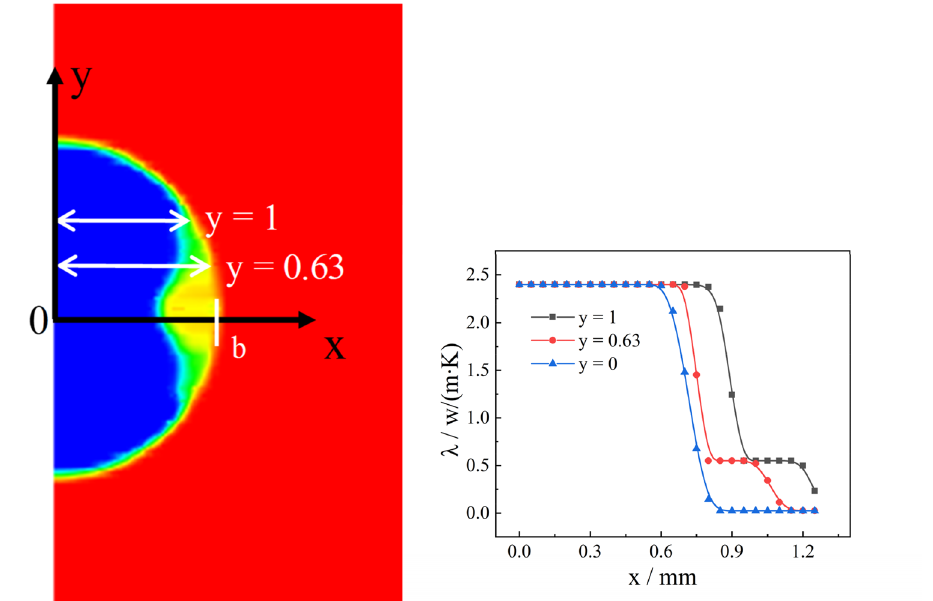
Figure 8. Radial thermal conductivity at 0.6 s for 1 mm droplets.